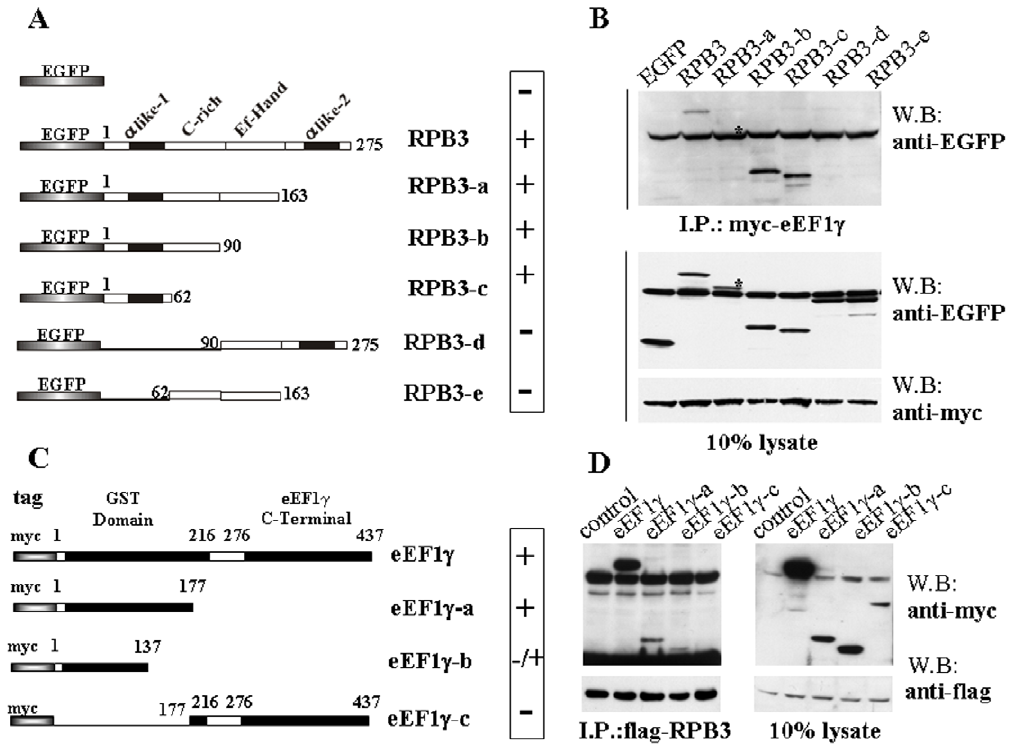
Figure 2. RPB3 and eEF1 c protein regions required for mutual interaction. A : Schematic representations of the EGFP-tagged full-length RPB3 and its derived deletion mutants. The construct designation and binding activity (to eEF1 c ) are indicated on the right side. B : Cell lysates from HeLa cells co-transfected with each indicated construct (EGFP, EGFP-RPB3 and EGFP-RPB3 nested deletion-mutants) and myc-eEF1 c were immunoprecipitated with the anti-myc antibody. Immunoprecipitated samples were analysed by western blot using the anti-EGFP monoclonal antibody to identify RPB3 domains involved in myc-eEF1 c interaction ( top ). The total cell lysates were immunoblotted to verify the correct expression of the transfected molecules (bottom). The asterisks mark the signal corresponding to the RPB3-a mutant (lane 3), partially covered by the heavy chain Ig band (top) and a non-specific band (bottom). C : Schematic representations of myc-tagged full-length eEF1 c and its derived deletion mutants. Constructs designation and binding activity (to RPB3) are indicated on the right side. D : Cell lysates from HeLa cells co-transfected with flag- tagged RPB3 and myc-eEF1 c deletion constructs were immunoprecipitated with the anti-flag monoclonal antibody. Co-immunoprecipitation was analysed by western blot using the anti-myc monoclonal antibody (left). The total cell lysates were immunoblotted to verify the correct expression of all the transfected molecules (right).